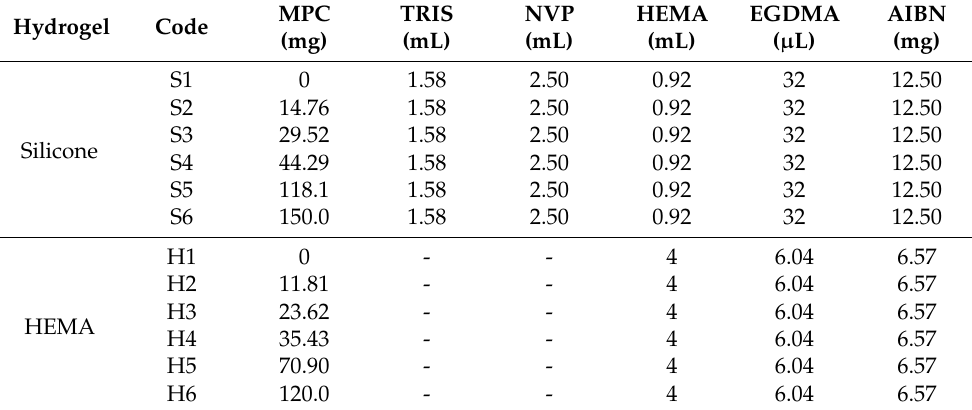
Table 1. Hydrogels composition